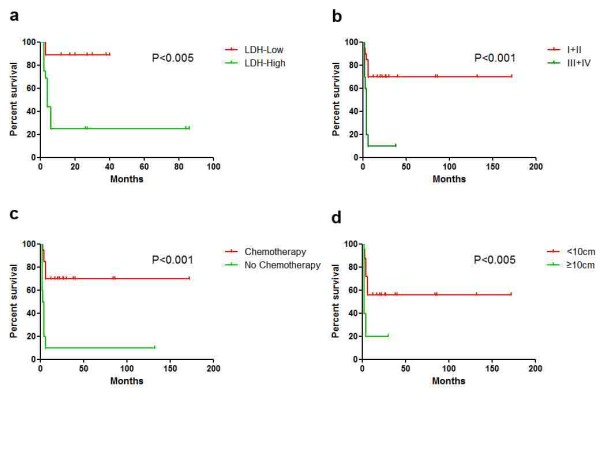
Survival curves of 30 treated patients with regard to different parameters showed (a) Patients with normal level of LDH(n = 11) had better prognoses over those with high level of LDH (n = 23)(P < 0.005); (b) patients with low stages (I & II, n = 20) had better prognoses over those with advanced stages (III & IV, n = 10)(P < 0.001); (c) patients who received chemotherapy (n = 20) had favorable outcomes than those who did not receive chemotherapy (n = 10)(P < 0.001); (d) patients with tumor size ≥ 10 cm (n = 5) has worse outcomes than those with size < 10 cm (n = 25)(P < 0.005).